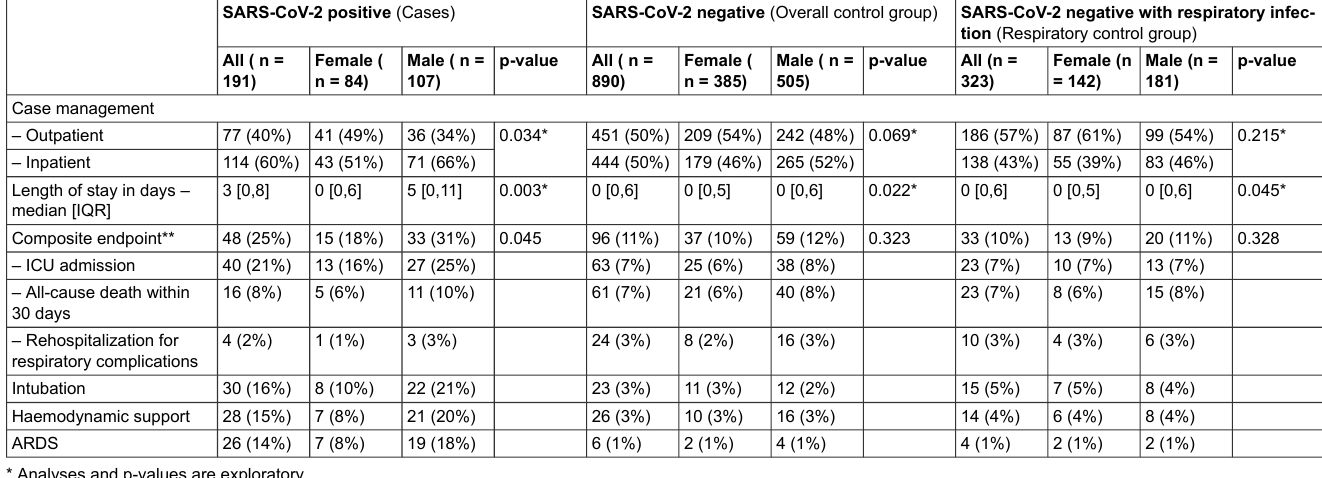
SARS-CoV-2 positive (Cases)